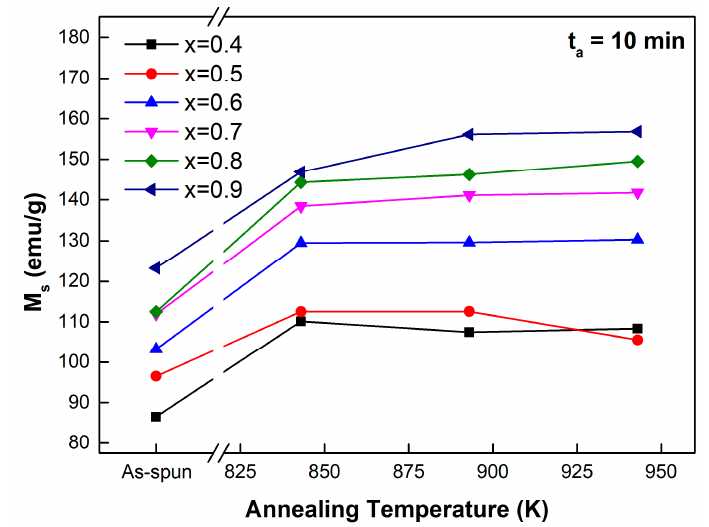
Figure 7. Variation of the saturation magnetization of the (Fe x Co 1 − x ) 72 B 19.2 Si 4.8 Nb 4 (0.4 ≤ x ≤ 0.9, at 0.1 intervals) as-spun and annealed ribbons for 10 min at 843, 893, 943 K, respectively.